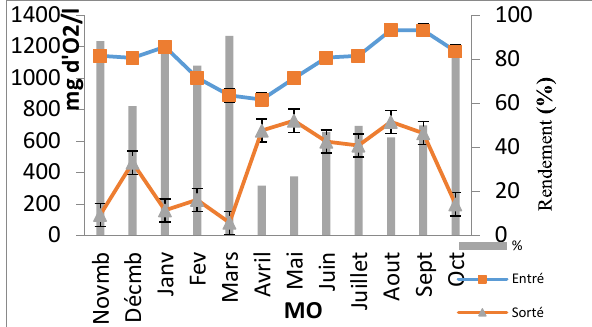
Figure 7. Variation of OM values at the entrance and exit of the WWTP